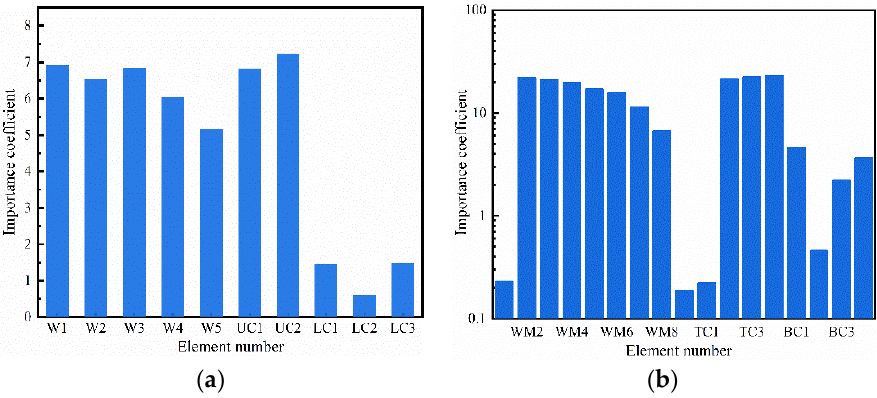
Figure 14. Importance coefficient (statistical objects: Lower chords): ( a ) test truss, ( b ) steel roof truss.